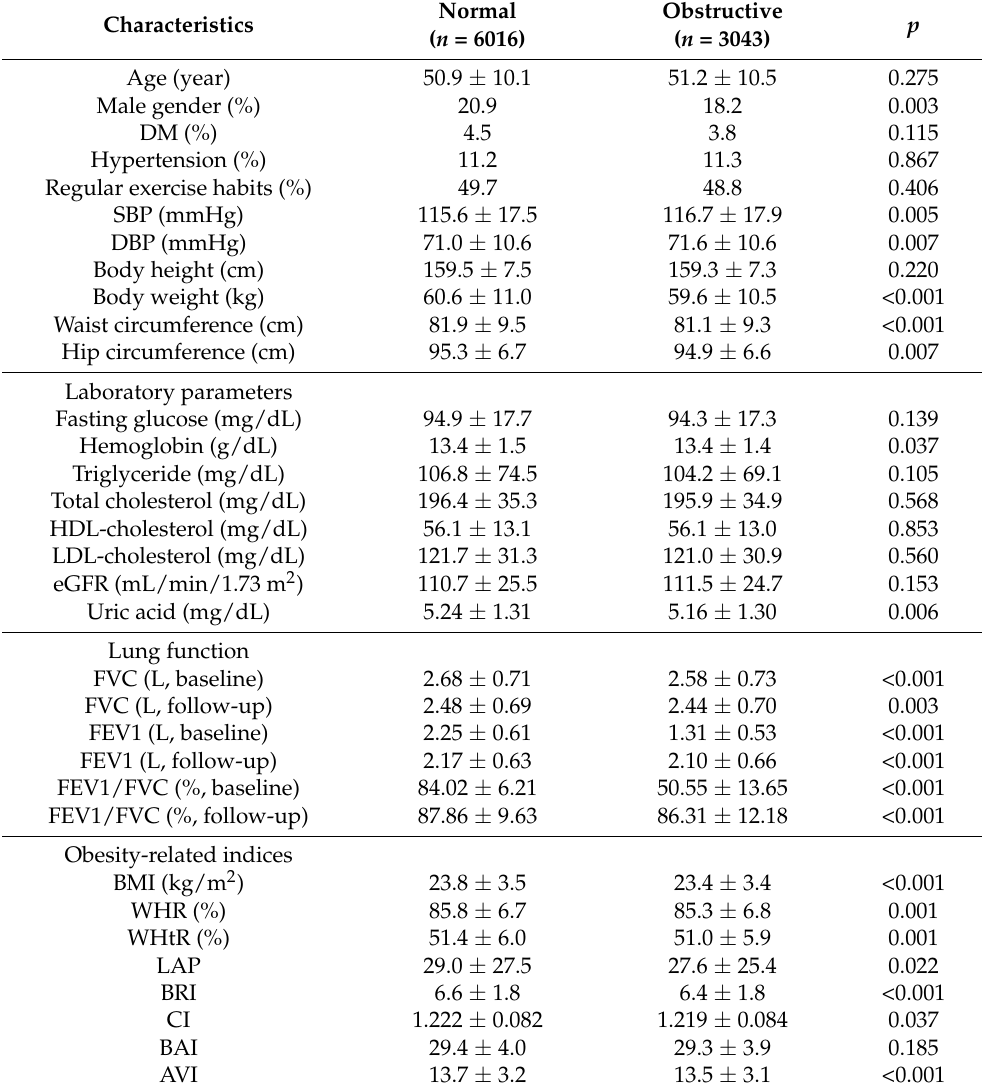
Table 1. Comparison of clinical characteristics among participants according to lung